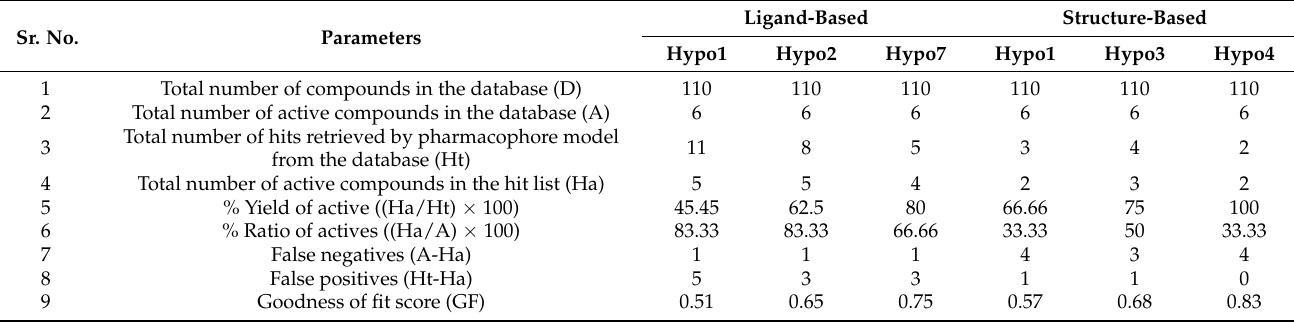
Table 3. Pharmacophore validation of ligand- and structure-based hypotheses by the Güner–Henry approach. Sr. No.